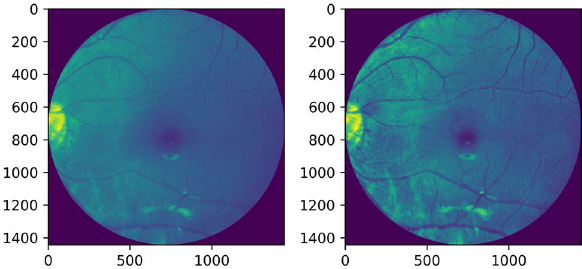
Figure 6. Grayscale image and its adaptive histogram equalization.